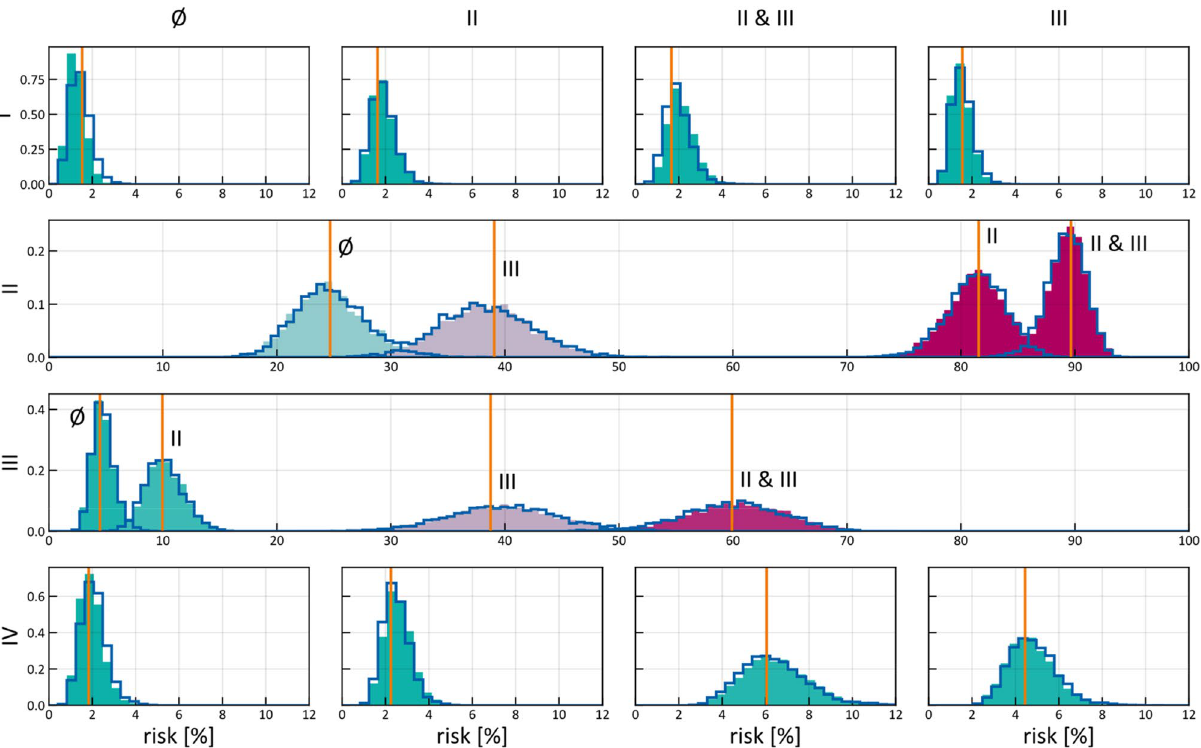
Figure 8. Risk assessment for the involvement of different LNLs (rows), given positive observational findings in specified LNLs (columns or labels next to histograms). E.g. row 3 depicts the risk of involvement in LNL III, given different observed involvements (from left to right: no involvement, LNL II only, LNL III only, and LNL II and III but no others). The orange line depicts the maximum likelihood result from (Pouymayou et al.) 31 , the blue outline histogram represents the BN sampling solutions and the solid coloured histograms are the results from the HMM. The colour goes from green (low risk) to red (high risk). Of 200,000 parameter samples, 2% were used to create this plot.